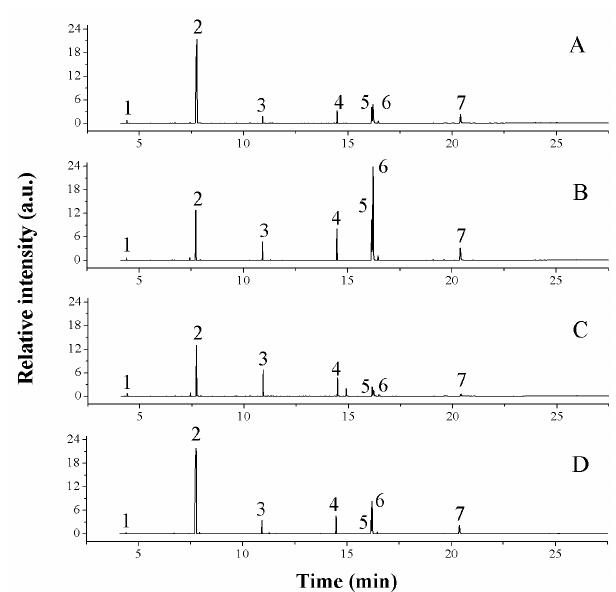
Figure 2. Chromatograms showing organic acid levels in the dried fruits of C. speciosa from four